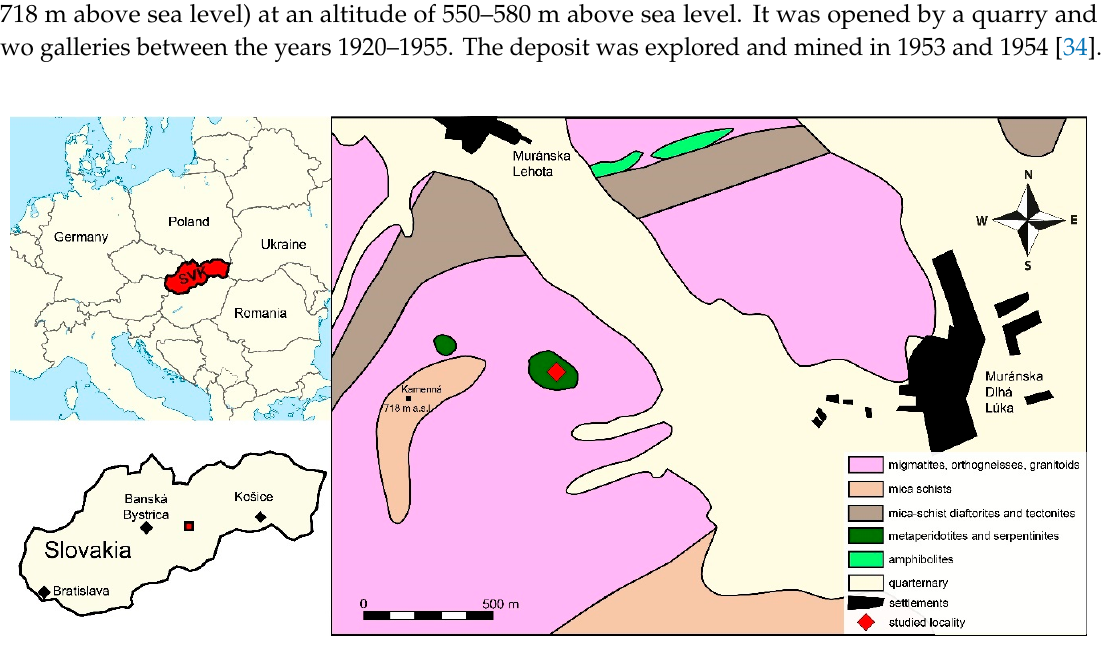
Figure 1. Geological sketch map of the Muránska Dlhá Lúka area (modified after [35]).